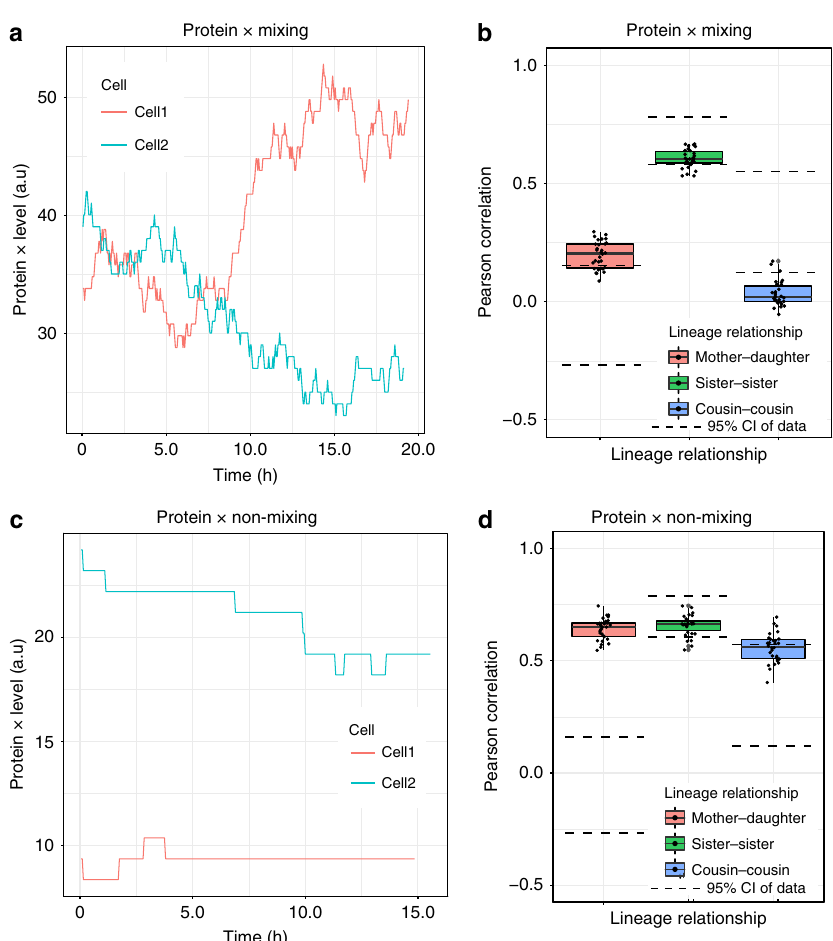
Fig. 4 A simple model of cell division control by fl uctuating protein levels cannot recapitulate the cousin-mother inequality. a Levels of protein X as a function of time during the lifetimes of two cells. The protein is said to be “ mixing ” since the production and degradation rates are high, leading to loss of memory of the initial protein level over the cellular lifetime. b Lineage correlations from 30 simulations (shown as black dots) generated by a model where the Protein X level passed on from mother to daughter cells control the hazard function for division of the daughters. As can be seen, the cousin-mother inequality cannot be recapitulated by this model and the mixing property of Protein X leads to negligible cousin correlations. c Protein X levels as functions of time in two cells when the protein is “ non-mixing ” : in this case, the production and degradation rates are low and hence the memory of the initial protein level is retained at the end of the cell ’ s lifetime. d Lineage correlations from 30 simulations (black dots) for the case of non-mixing Protein X. Once again the cousin – mother inequality cannot be explained, and the non-mixing property of Protein X leads to very large mother – daughter correlations. Parameters for the models in both b and d were chosen to recapitulate the correct sister correlation as observed in our experimental data (details in Supplementary section 6). The boxplots represent the 1st, 2nd, and 3rd quartiles of the lineage correlations generated in the